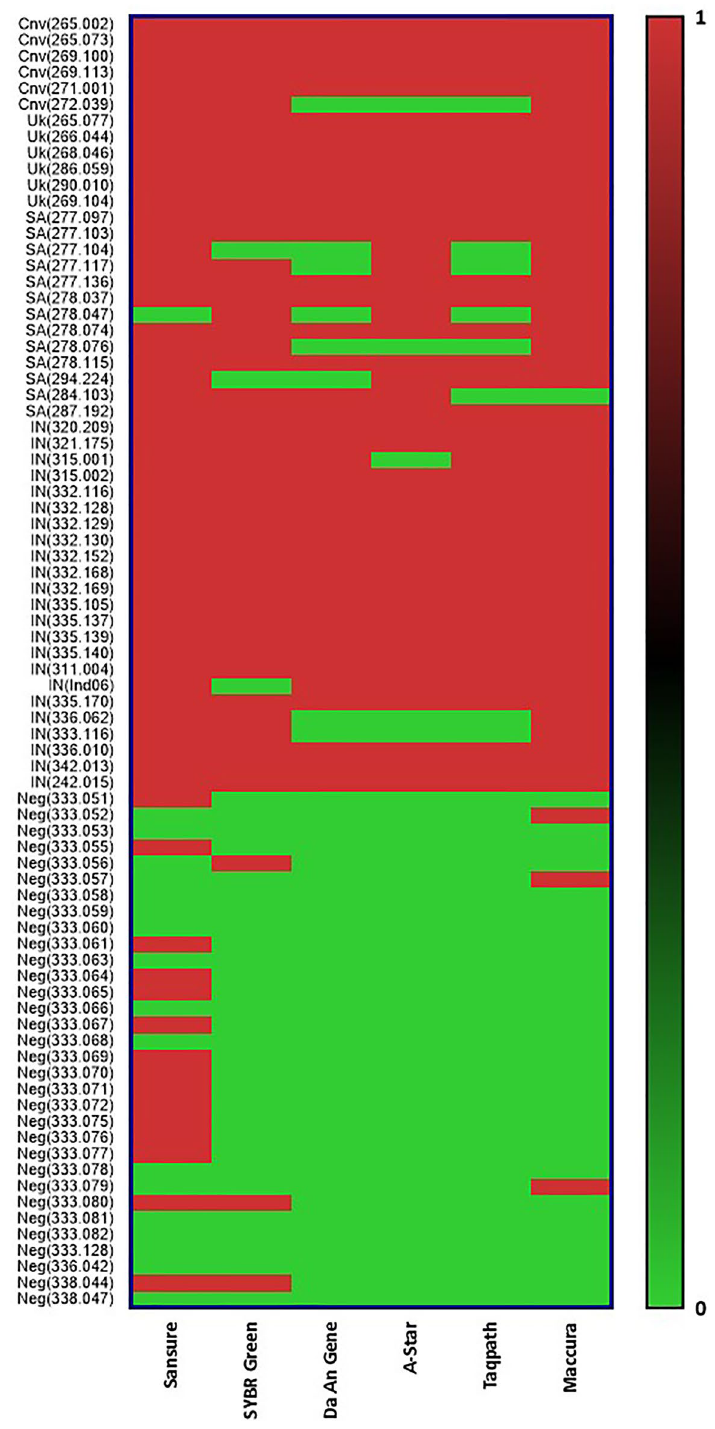
Figure 2. Visualization of screening positive and negative samples is associated with SARS-C0V-2 variants of concern. Screening positive samples represented as “1” & negative samples represented as “0”. SARS-CoV-2 variant shown as Cnv = Conventional/Wild Type, UK = UK variant (ALPHA, B.1.1.7), SA = South Africa Variant (BETA, B.1.351), IN = Indian Variant (DELTA, B.1.617.2) and Neg = Negative. Further confirmed by Sanger